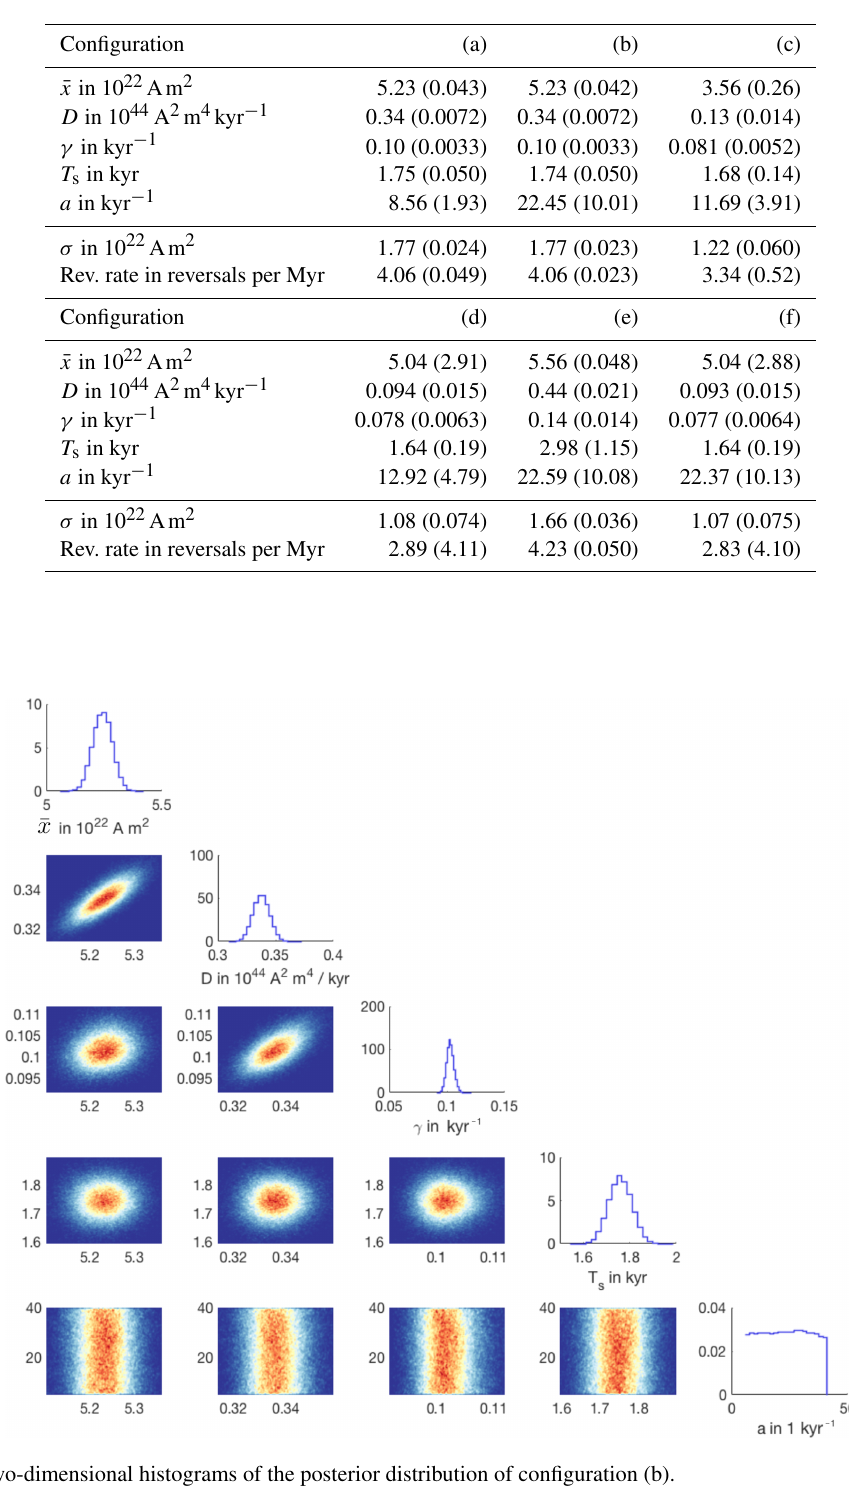
Table 6. Posterior parameter estimates (mean and standard deviation, in brackets) and corresponding VADM standard deviation ( σ ) and reversal rates for five different setups (see Table 5).